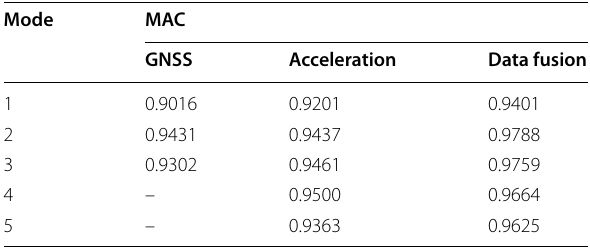
Table 4 The MAC values of GNSS-derived, acceleration-derived and data fusion-derived